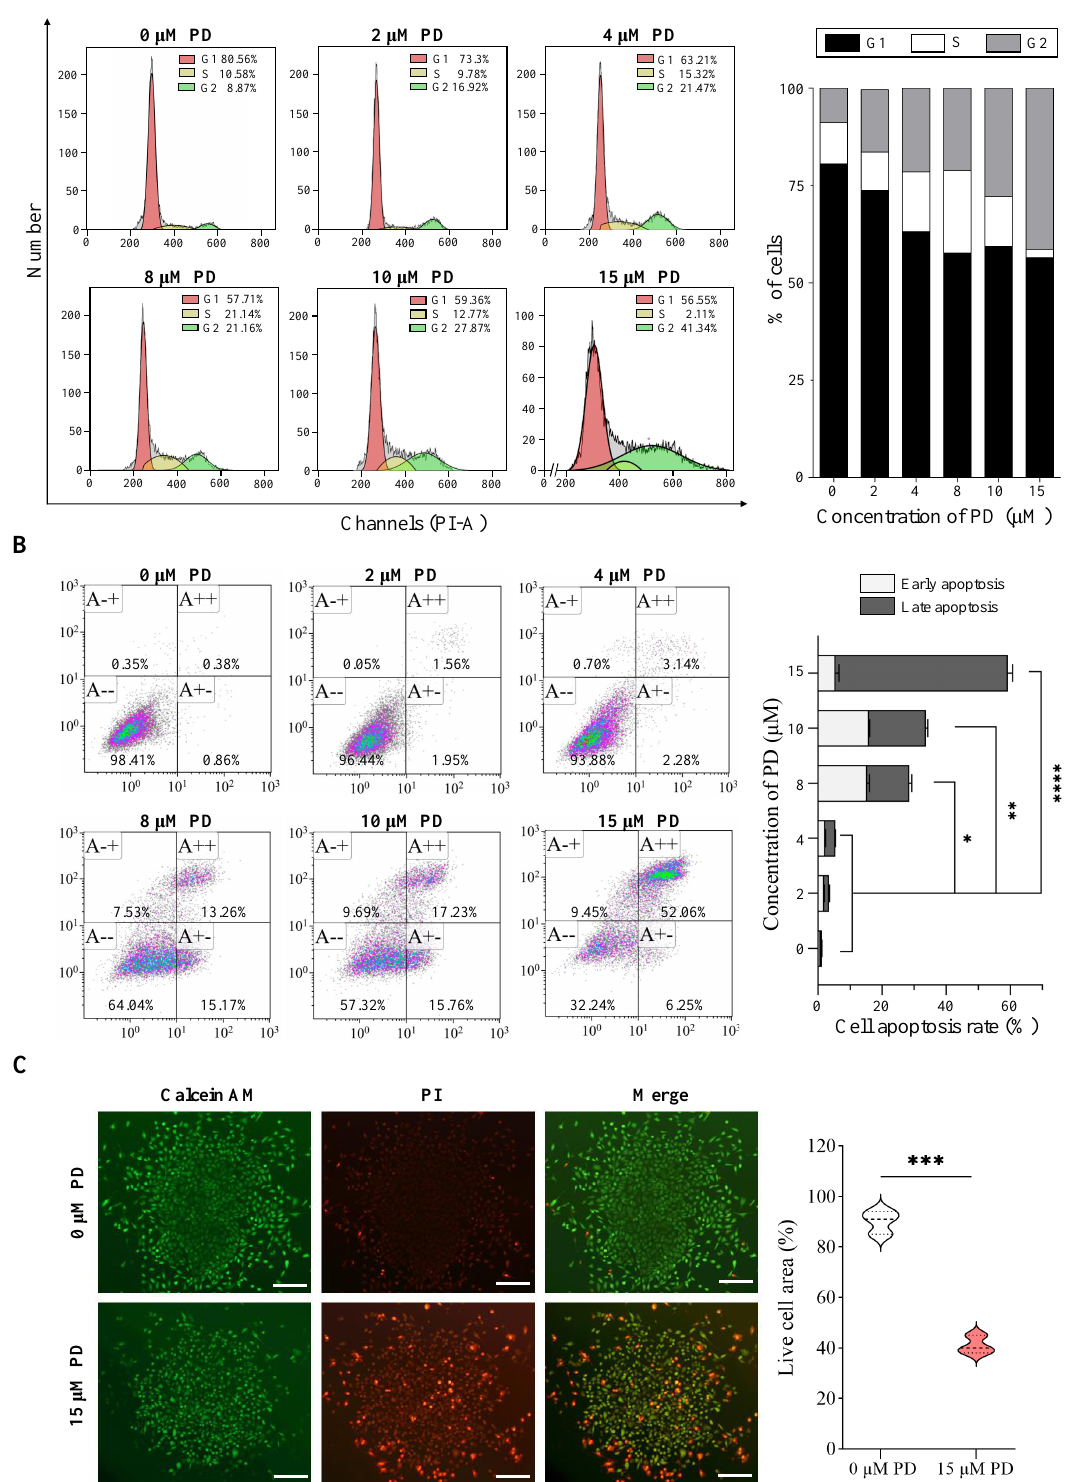
Figure 11. PD suppresses cell proliferation and colony formation, and induces cell apoptosis in A549 Cells. Flow cytometry results show the cell cycle changes ( A ) and apoptosis induction ( B ) in PD-treated A549 cells. ( C ) Colony formation. Live cells are stained by Calcein–AM (green color), and dead cells are stained by PI (red color). Scale bar: 100 µ m * p < 0.05; ** p < 0.01; *** p < 0.001; **** p <